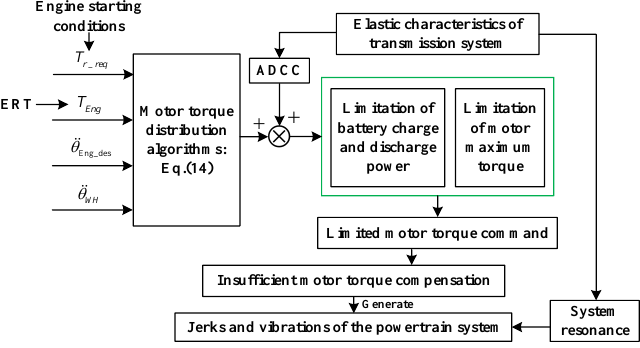
Figure 7. Problem description during engine starting process.